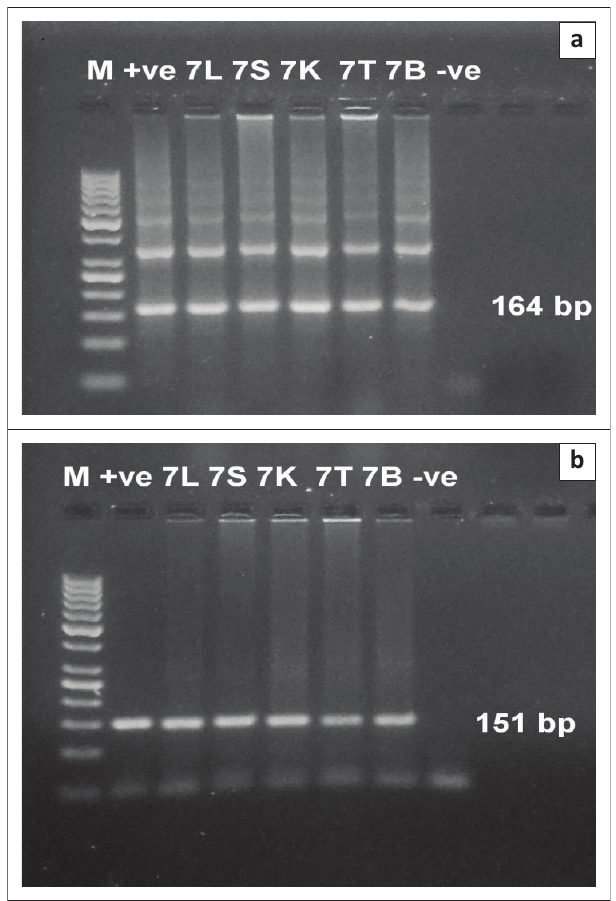
FIG URE 7: Polymerase chain reaction amplification of Deoxyribonucleic acid extracted from tissues of infected male mice (chronic) using (a) Trypanosoma brucei primer set and (b) T. evansi Rode Trypanozoon antigen type primer set. M: 50 base pairs molecular weight Deoxyribonucleic acid marker, +ve: positive control, -ve: negative control, 7: days post infection and L (liver), S (spleen), K (kidneys), T (testes) and B (brain).